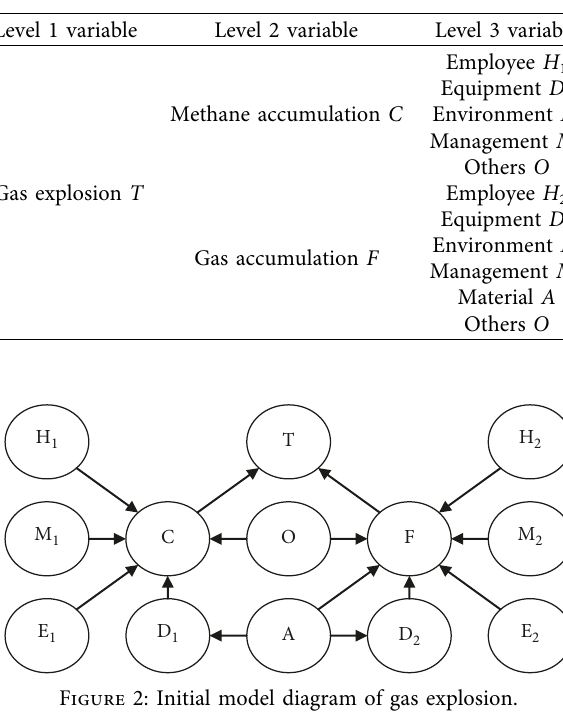
Table 1: Related variables.